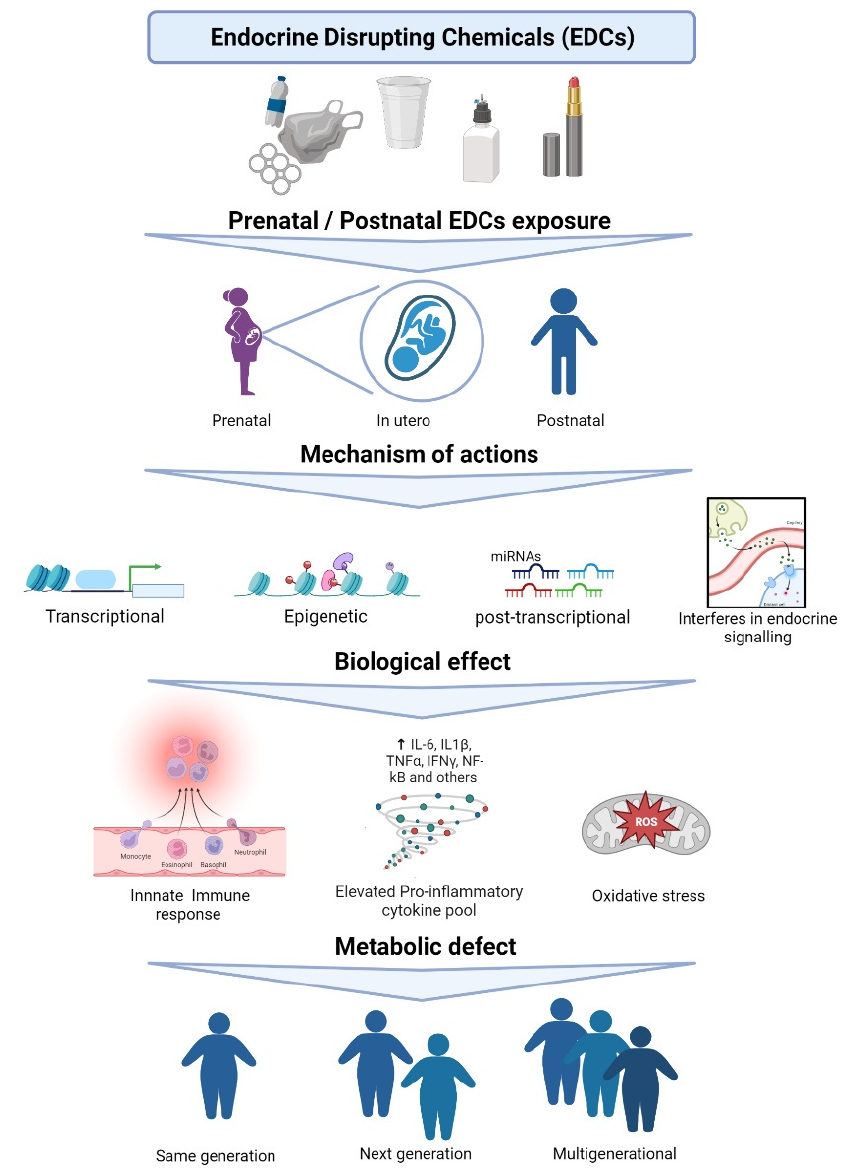
Figure 1. Various mechanisms of actions of EDC leading to metabolic health defects.